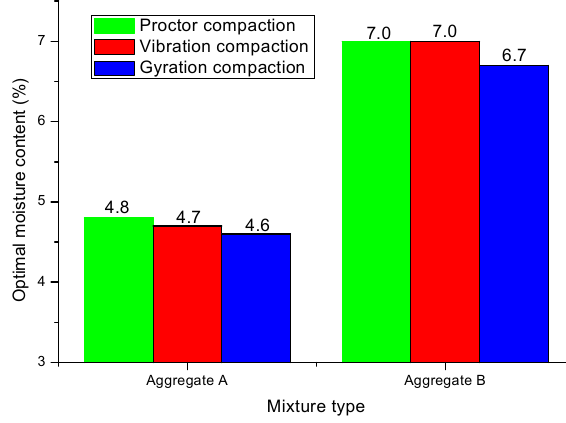
( b ) Figure 8. Schematic diagrams of aggregate degradation for ( a ) Aggregate A and ( b ) Aggregate B. Both Figure 8a,b indicate that aggregate particles with a size over 19 mm degraded the most seriously. This was because large-sized particles, which generally undertook skeleton effects, were crushed more easily when subjected to impact energy. Due to the combined effect of increasing particles passing a larger-sized mesh and decreasing the crushed particles with a small size, the aggregates passing 9.5 mm and the smaller mesh decreased, indicating that the small-sized aggregate particles were harder to crush. On the whole, the aggregates after gyration compaction degraded the least, indicating that gyration compaction could better maintain the skeleton of CTAM. 4.2.2. Maximum Dry Density and Optimal Moisture Content